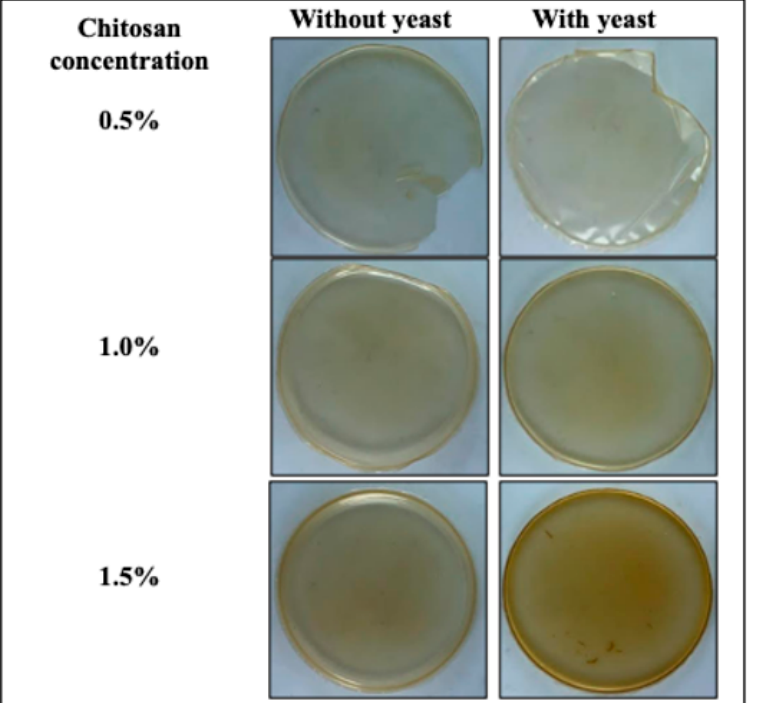
Figure 4. Chitosan-based films with or without marine Figure 4. Chitosan ‐ based films with or without marine yeast.